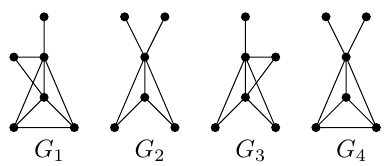
Figure 2: Four 6-vertex nonregular graphs with the same total